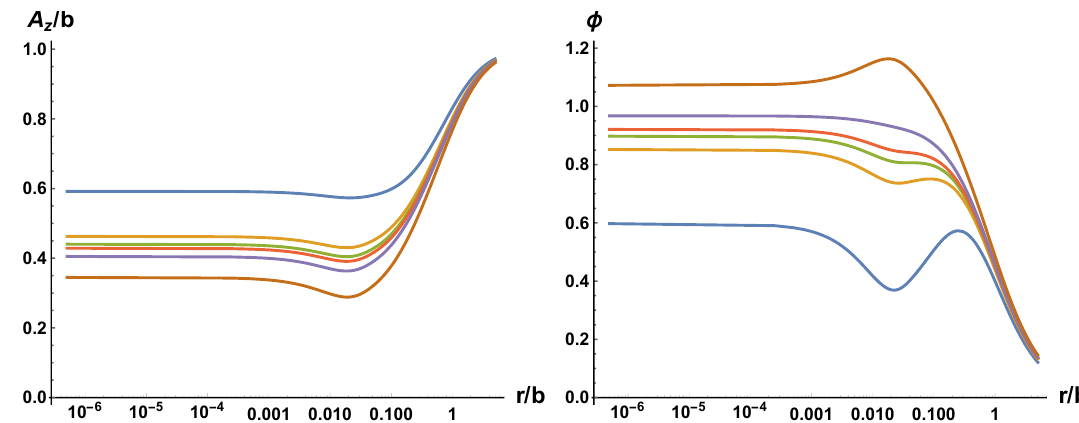
Figure 8. Log-linear plot of the bulk pro(cid:12)les for the gauge (cid:12)eld A z ( r ) and the scalar (cid:12)eld (cid:30) ( r ) at (cid:22) T = 0 : 05. The various colors (from blue to brown) are (cid:22) M = 0 : 66 ; 0 : 724 ; 0 : 736 ; 0 : 743 ; 0 : 757 ; 0 : 8. The phase transition can be seen from the a large shift og the near-horizon values of the bulk (cid:12)elds when (cid:22) M exceeds 0 : 744.